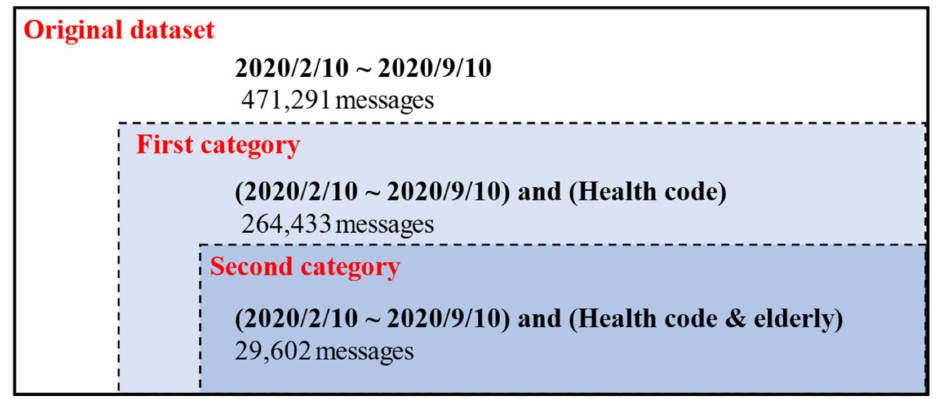
Figure 4. Description of Weibo data in the stages of data collection and